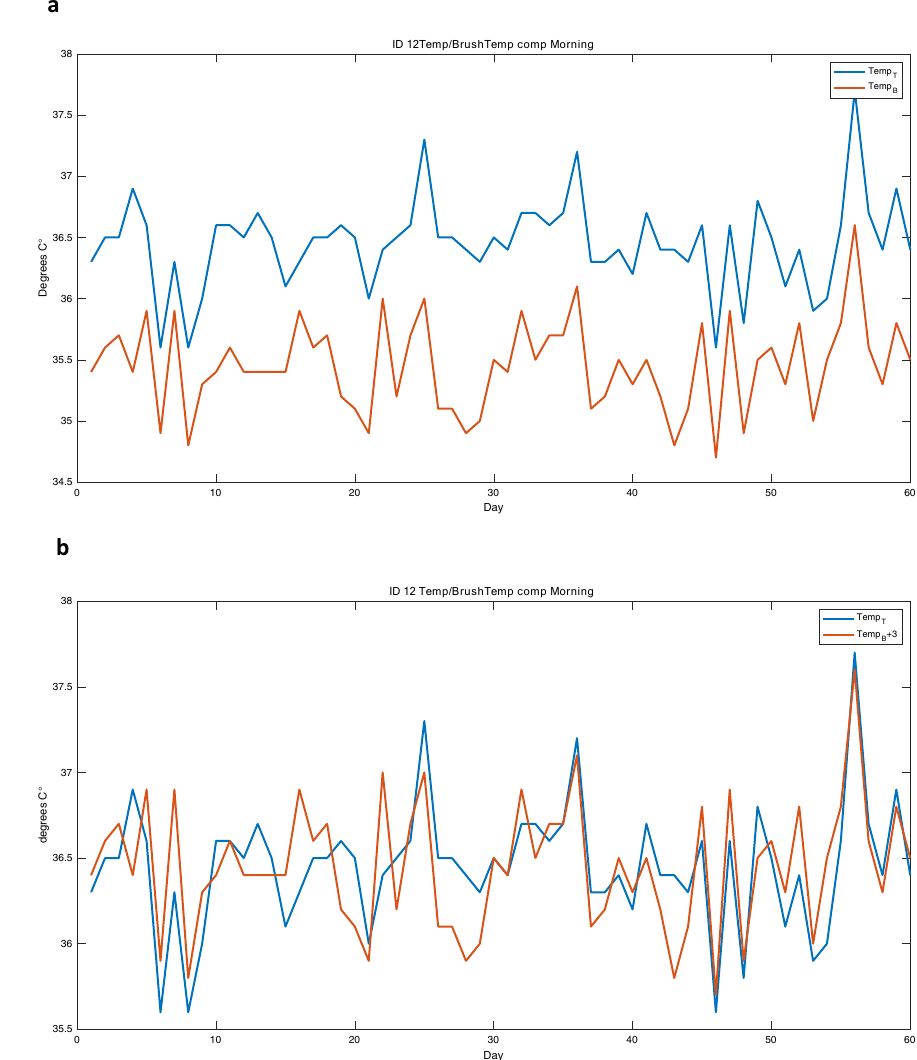
Fig. 2 a Morning measured values T and BT for ID12. b Morning measured values T and BT + mean diff for